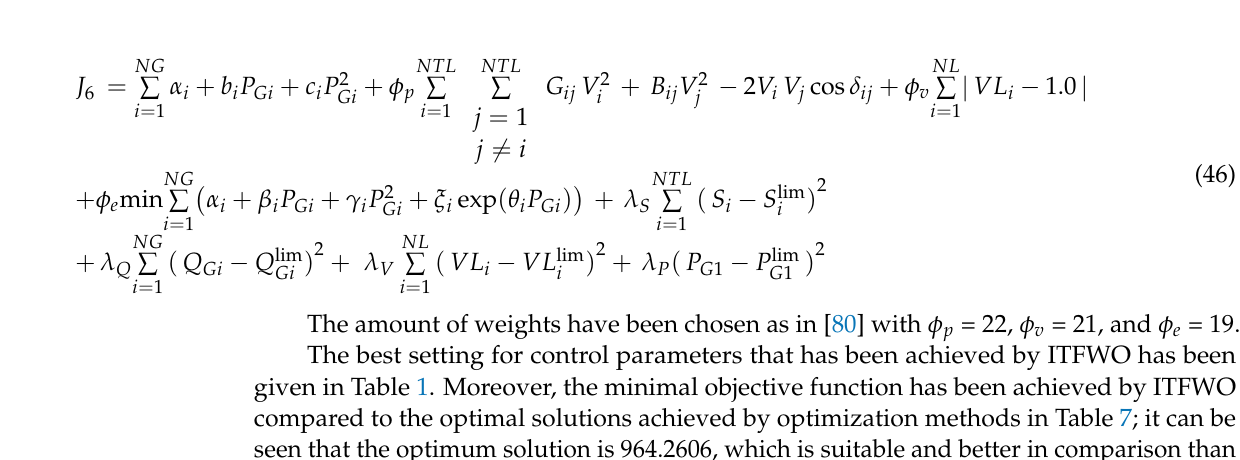
Table 7. The optimization results for Type 6.